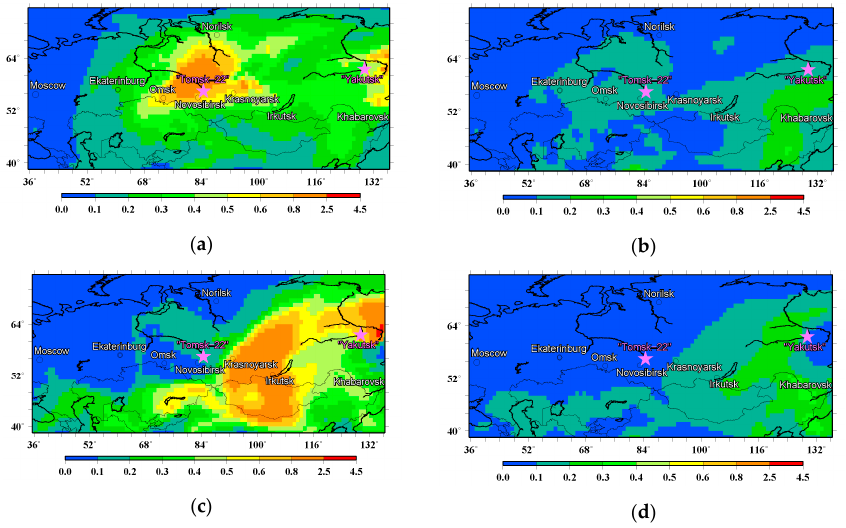
Figure 2. Averages of absorption optical depth (AOD) at 500 nm according to the CHIMERE simulations performed ( a , c ) with and ( b , d ) without fire emissions. The averages are calculated only over the data and hours that were supplied with the selected measurement data from the ( a , b ) Tomsk-22 and ( c , d ) Yakutsk AERONET sites for the period of the June–August 2012. The locations of the AERONET sites considered are indicated by purple asterisks.